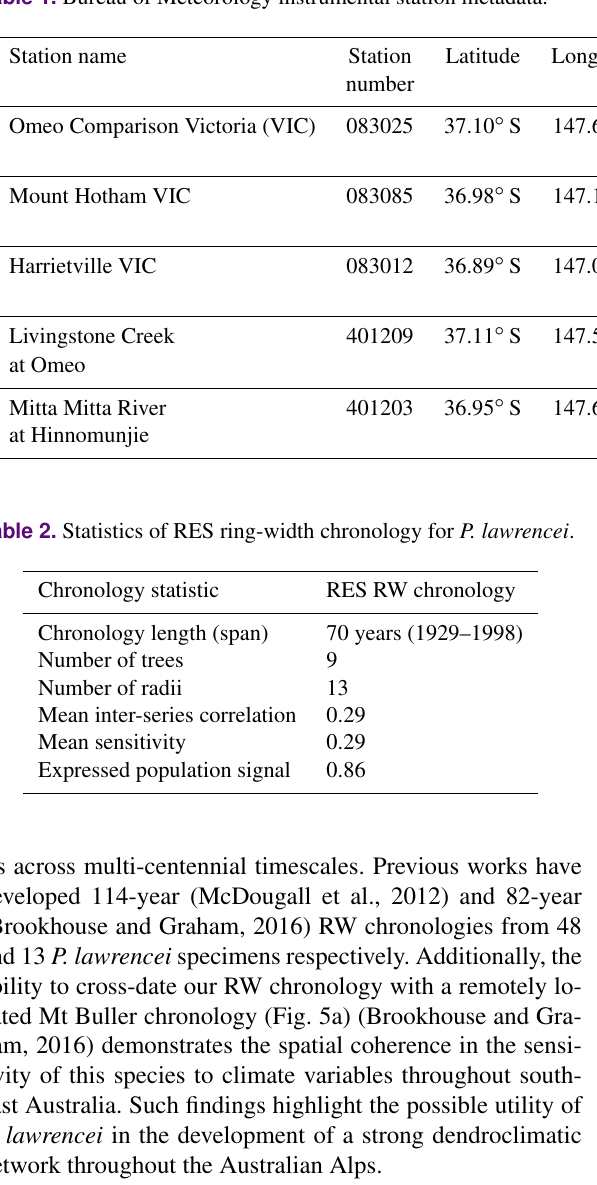
Table 1. Bureau of Meteorology instrumental station metadata.